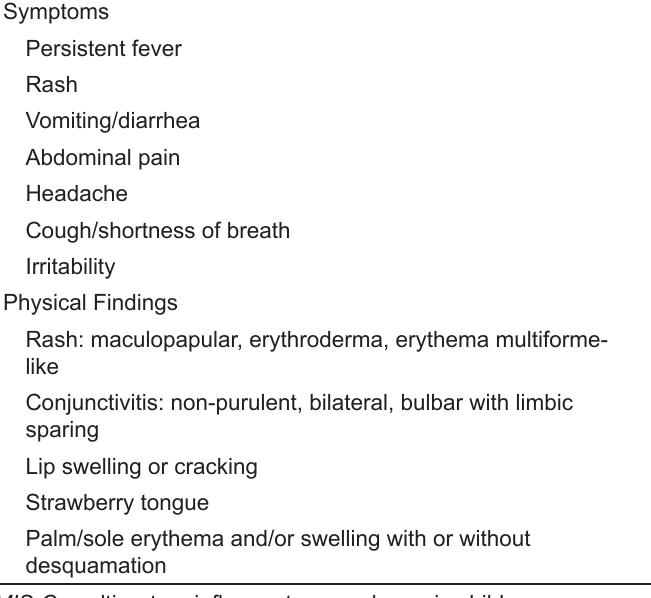
Table 1. Clinical characteristics reported in multisystem inflamma - tory syndrome in